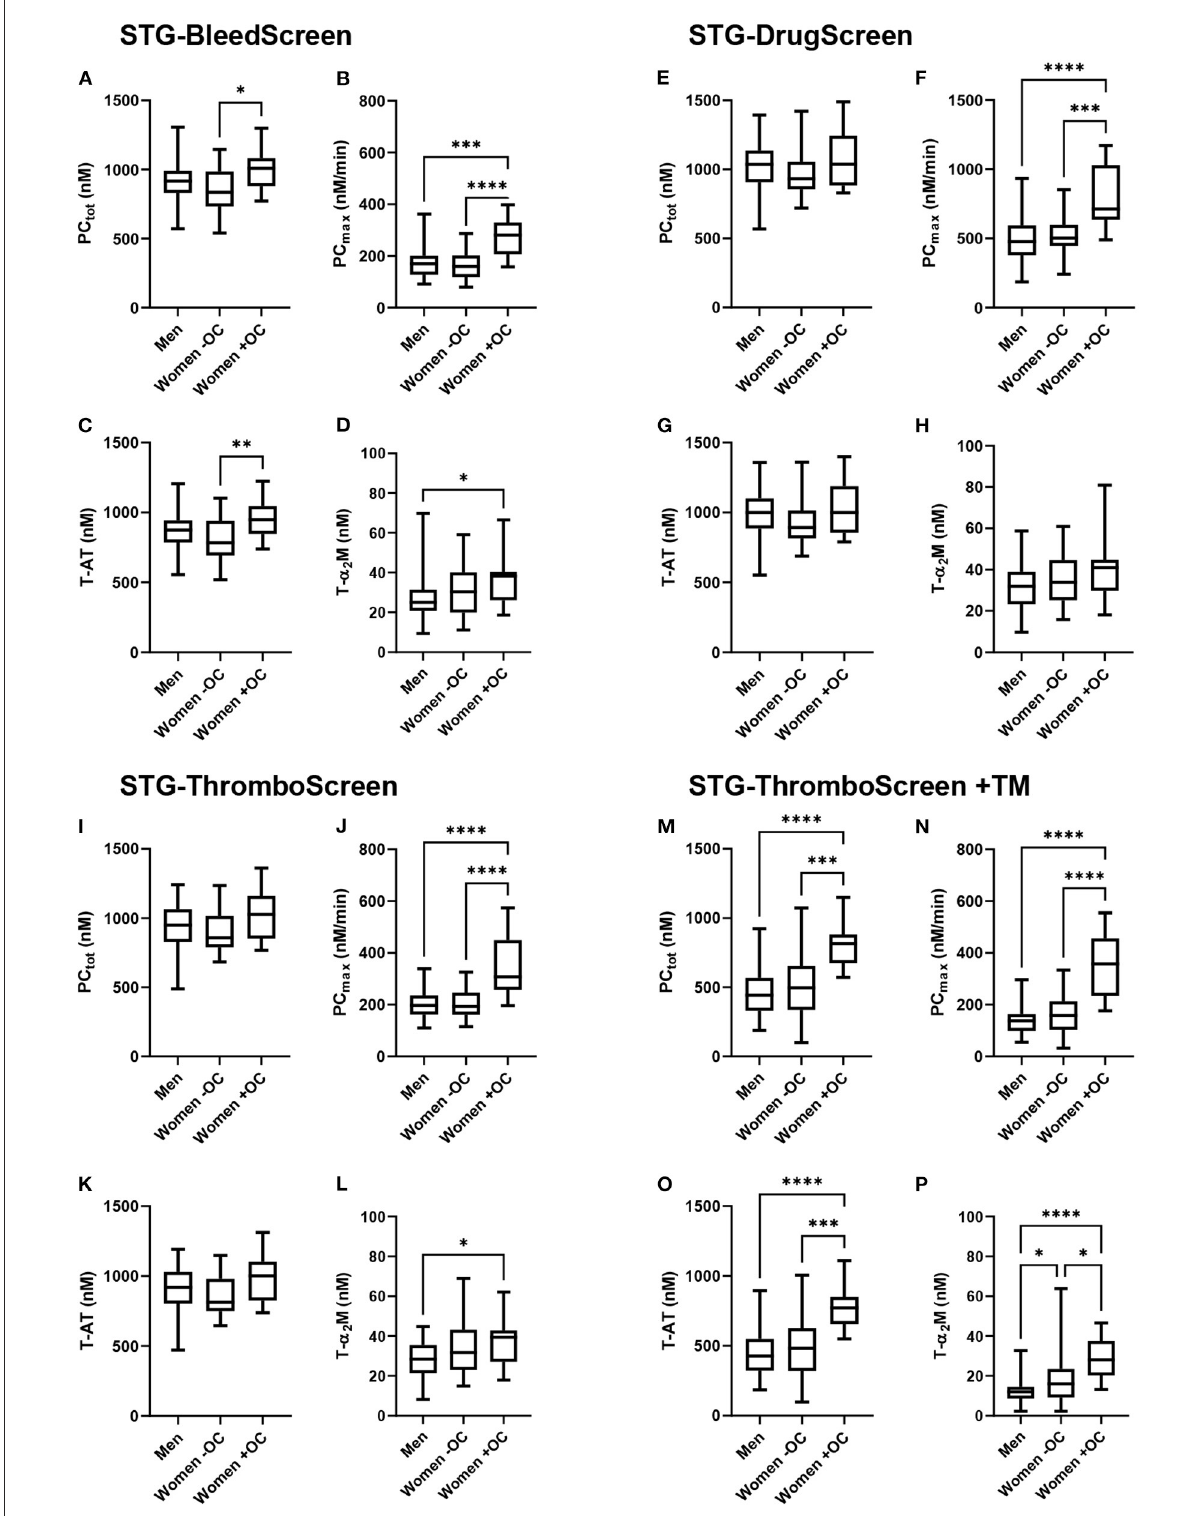
FIGURE2 Thrombin dynamics parameters obtained from thrombin generation measured with the ST Genesia stratified for sex and oral contraceptive use. TG was measured with the STG-BleedScreen (A–D) . STG-DrugScreen (E–H) , STG-ThromboScreen without TM (I–L) , and STG-ThromboScreen with TM (M–P) . TD parameters PCtot (A,E,I,M) , PCmax (B,F,J,N) , T-AT (C,G,K,O), and T- α 2 M (D,H,L,P) complexes are depicted for each group: men, women without OC and women with OC. Data are median with IQR and minimum and maximum values. tot, total; max, maximum; T-AT, thrombin-antithrombin complex; T- α 2 M, thrombin- α 2 M complex; TM, thrombomodulin. * P ≤ 0.05, ** P ≤ 0.01, *** P ≤ 0.001, **** P ≤